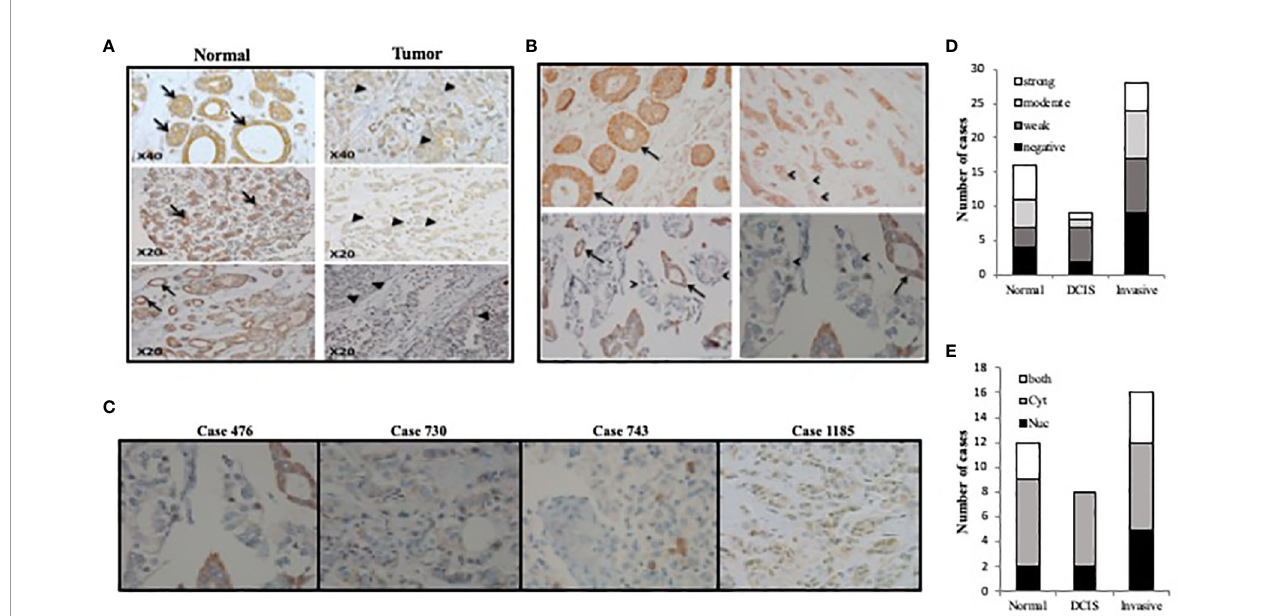
FIGURE 1 | TET1 expression pattern in breast cancer samples. (A) Representative images of TET1 IHC staining showing loss or weak staining of TET1 in malignant cells (right panel, arrow heads) compared to benign or normally appearing cells of mammary tissue alveoli or ducts (left panel, arrows). (B) Correlation between TET1 expression and differentiation level in breast cancer samples. Representative images of TET1 IHC staining showing loss or decreased levels of TET1 expression in poorly differentiated (arrow heads) compared to well differentiated tissue (arrows). (C) Representative images of TET1 IHC staining showing different expression level ranging from heterogeneous (case 476), weak (case 730), negative (case 743), and mixed cytoplasmic and nuclear (case 1185) staining. Brown color indicates positive staining for TET1. (D, E) Statistical analysis of IHC staining showing the heterogeneity of TET1 staining strength and distribution in different tissue